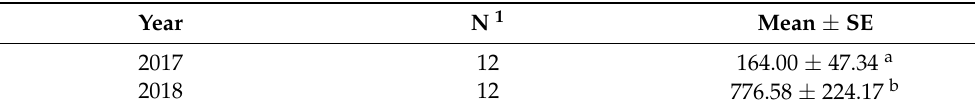
Table 6. Average numbers of adult D. suzukii collected on blueberries using Scentry ® traps during the sampling periods in 2017 and